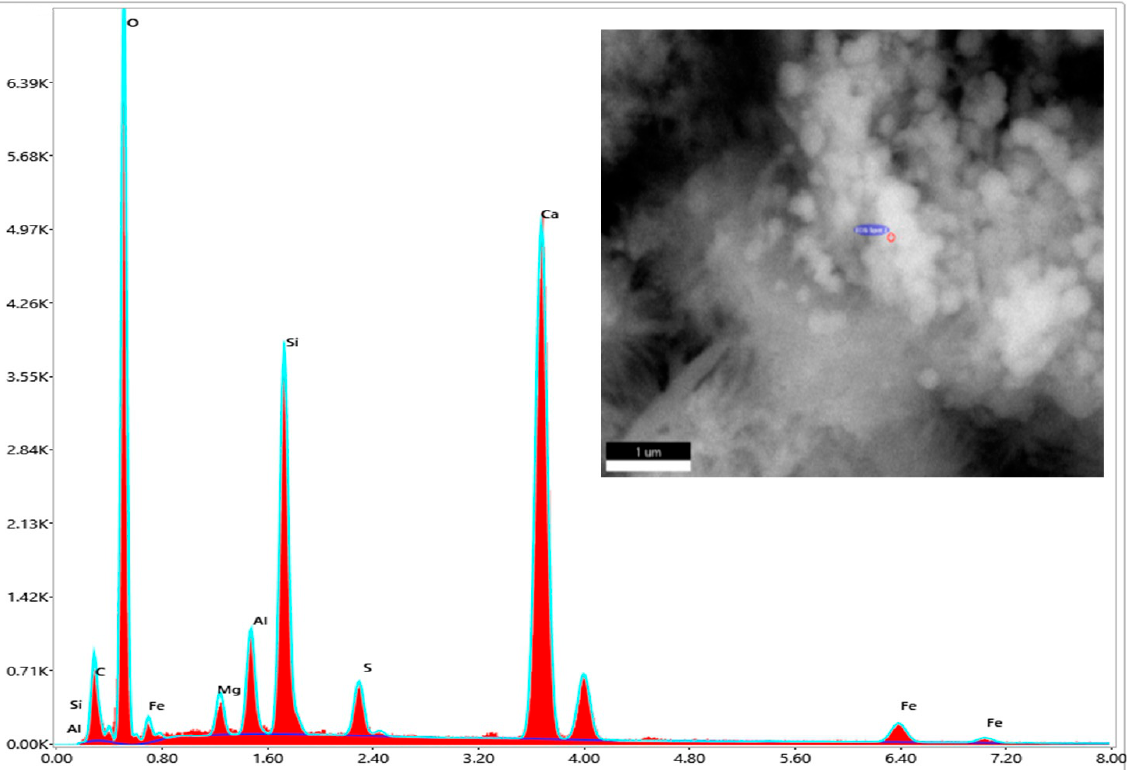
Figure 10. X-ray microanalysis of spherical hydration products.